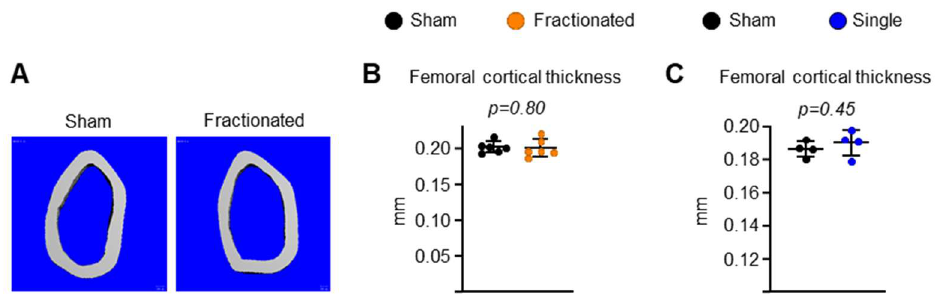
Figure 3. IR does not alter cortical bone mass in young adult male mice. ( A ) Representative 3D cortical bone images of femora from 8.5-month-old male C57BL/6 mice. ( B ) Cortical thickness in femoral diaphysis from fractionated TBI mice and sham controls measured by µCT. n = 6 animals/group. p values by Student’s t -test. ( C ) Cortical thickness in femoral diaphysis from single TBI mice and sham controls measured by µCT. n = 4 animals/group. Data are presented as ±SD. p values were determined using Student’s t test.